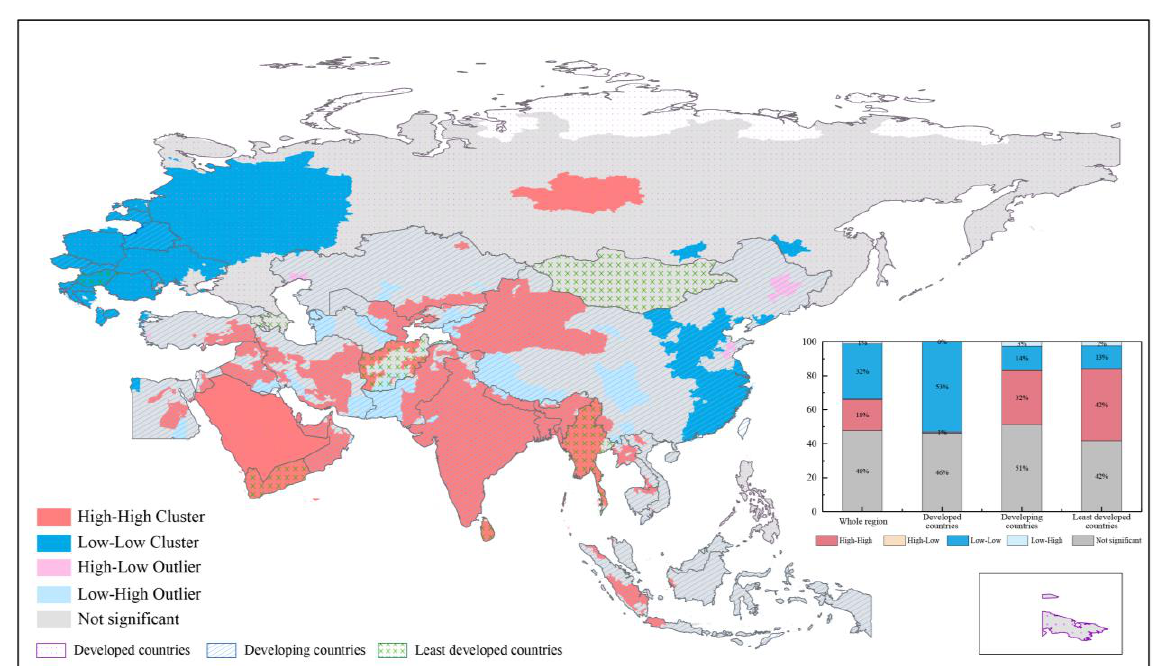
Figure 8. The cluster map of slope for PWEL of PM 2.5 concentration in B&R region from 2000 to 2020.